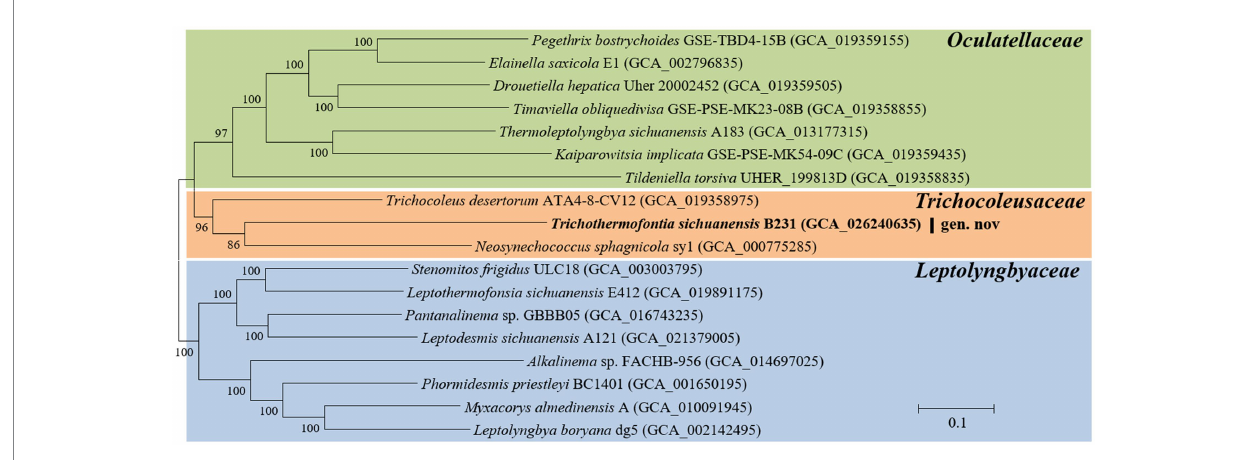
FIGURE 2 ML phylogenomic inference of concatenated protein alignment of 647 single-copy genes shared by all genomes. Strain no. in bold represent the strain identified in this study. Bootstrap values are indicated at nodes. Scale bar = 10% substitutions per